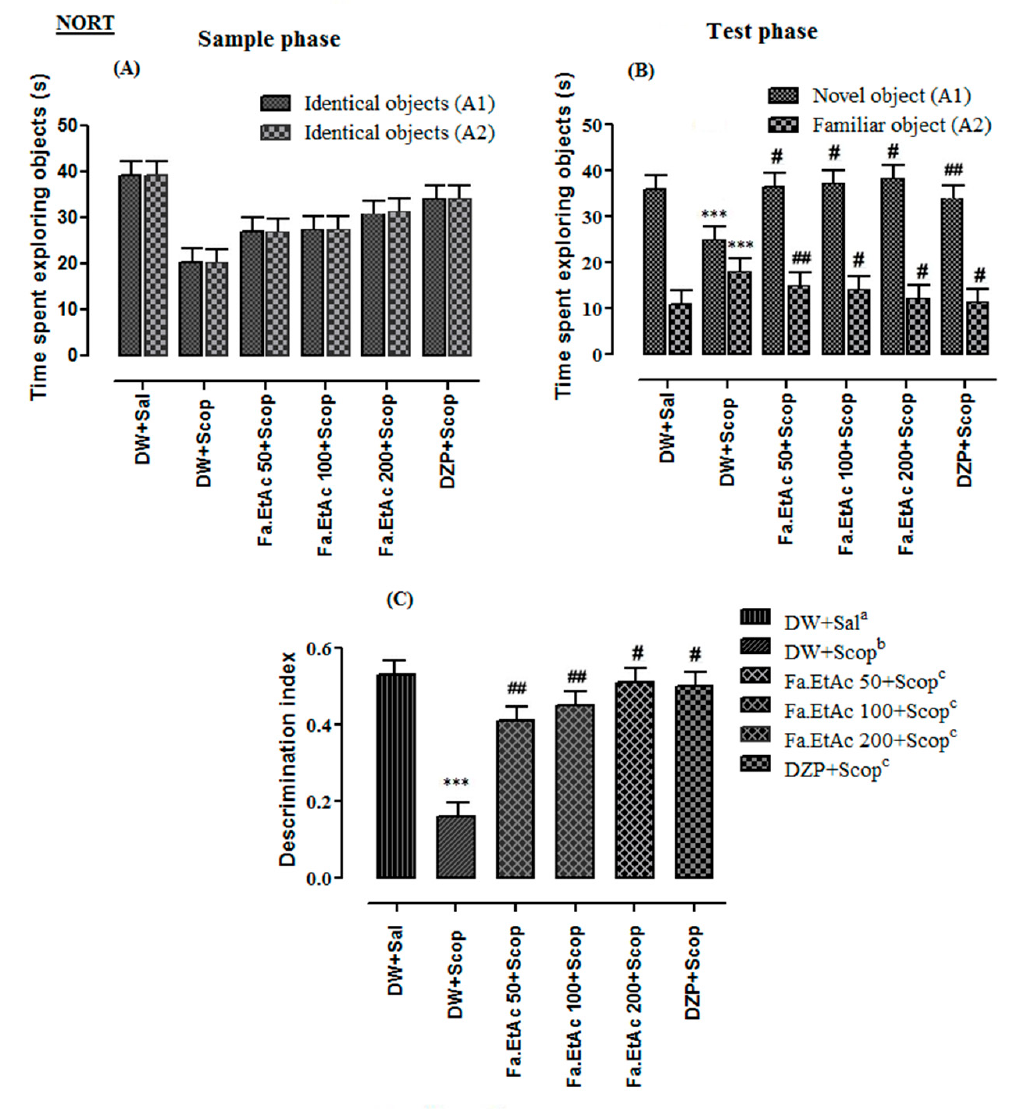
Figure 4. Effect of Fa.EtAc fraction of Ferula ammoniacum (D. Don) on mice in behavioural NORT ( A ) Time spent in the sample phase ( B ) Time spent in the test phase ( C ) % Discrimination index were recorded in Fa.EtAc (50, 100 and 200 mg/kg)-treated groups versus scopolamine (Scop. 1 mg/kg)-treated group for assessment of recognition memory in mice model in behavioural NORT. The data are expressed as Mean ± SEM; each value corresponds to a mean of eight animals. One-way ANOVA followed by Dunnett’s post hoc multiple comparison test to determine the values of p . *** p < 0.001; comparison of DW + Sal a (Normal control) vs. DW + Scop b (Scopolamine-treated group), # p < 0.05 and ## p < 0.01; comparison of (DW + Scop) b vs. DZP + Scop c (Donepezil treated) and Fa.EtAc c (50, 100 and 200 mg/kg)-treated groups using one-way ANOVA followed by Dunnett’s post hoc multiple comparison test.